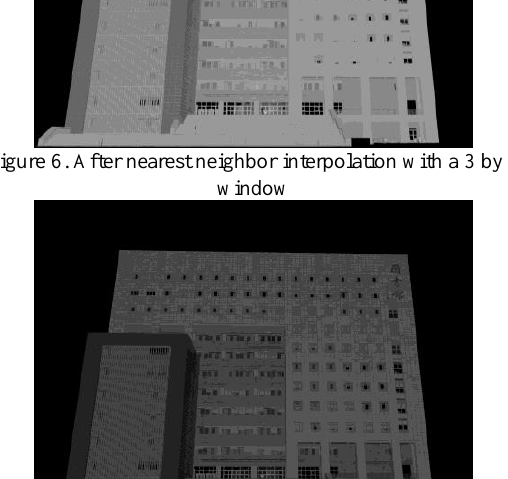
Figure 7. Gamma correction